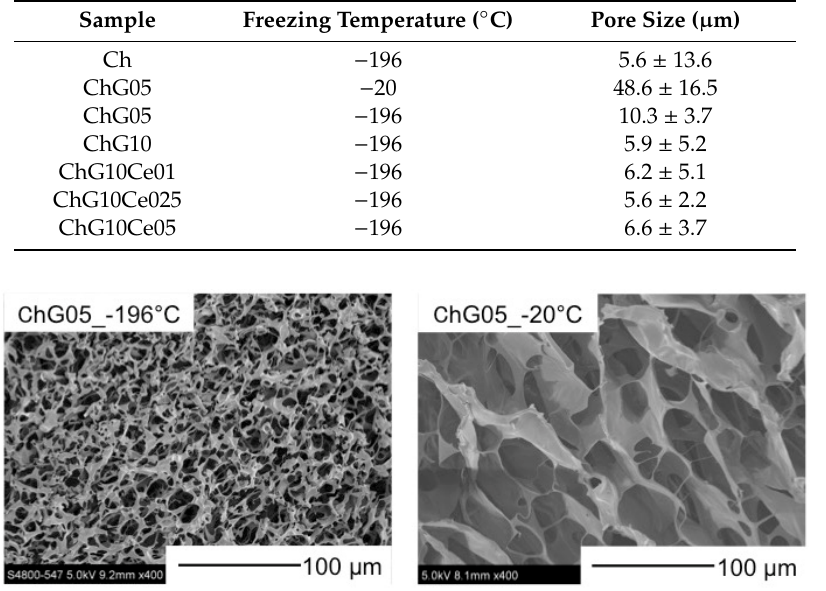
Figure 4. SEM images of surfaces of ChG05 chitosan-siloxane hybrid spheres prepared at − 20 and − 196 °C. Table 2. Pore sizes of the chitosan − siloxane spheres.